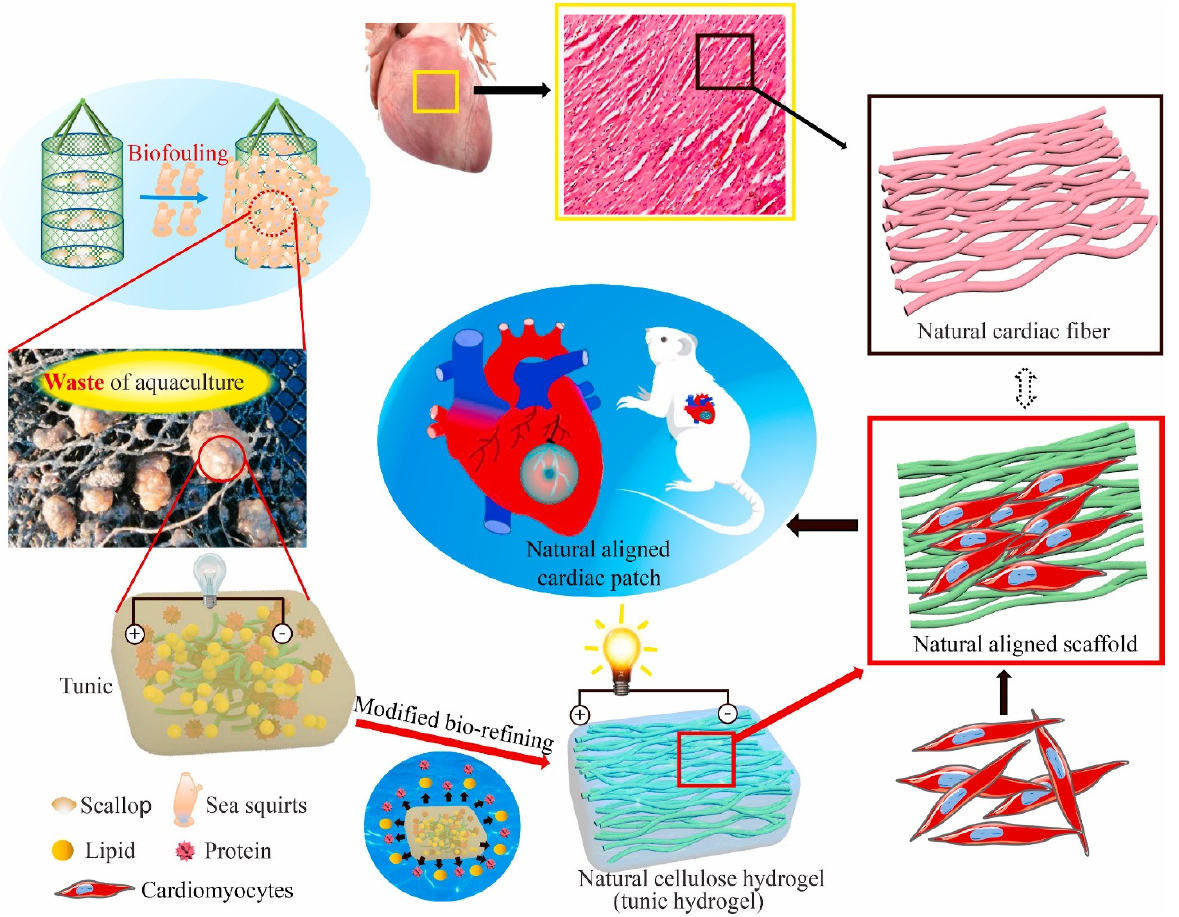
Figure 4. Sea squirts-derived cardiac patch for myocardial infarction from the waste of marine culture. Adapted from [59] .